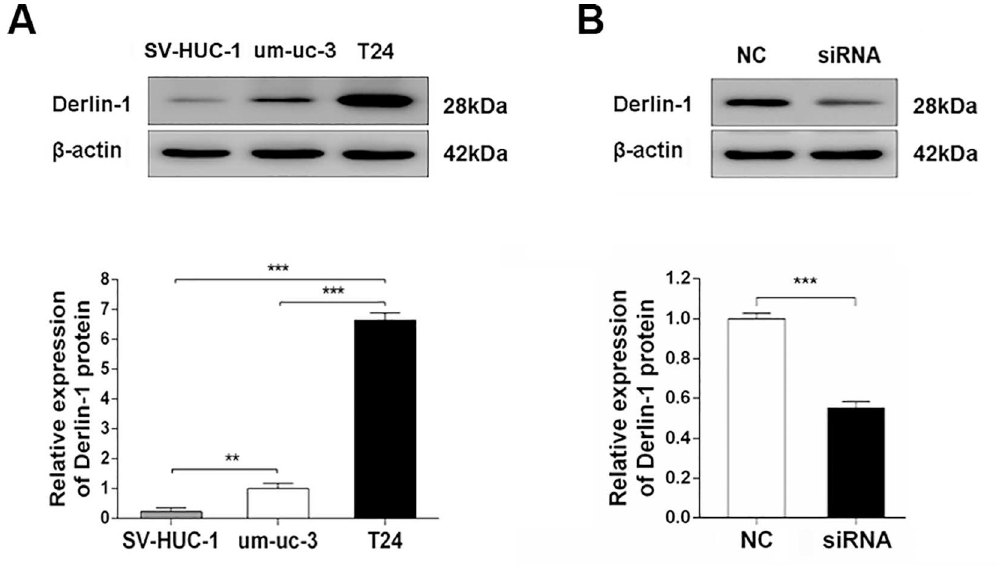
Fig 5. Expression of Derlin-1 protein in human bladder cell lines. (A) Expression of Derlin- protein using western blotting in SV-HUC-1 cells, um-uc-3 cells and T24 cells. (B) Interfere of Derlin-1in T24 cells. Cells were transfected with nontargetingsiRNA or Derlin-1 siRNA for 48h, and the protein expressionwas detected by western blotting. NC, siRNA negativecontrol; siRNA, Derlin-1siRNA. Data are expressedas the mean ± S.D., ** P < 0.01, *** P <